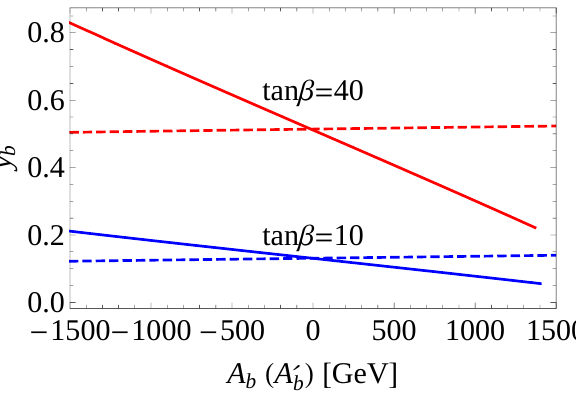
Figure 2 . Variation of y b as a function of A 0 (in the NHSSM with A b = 0; bold lines) and A b (in b the MSSM; broken lines) for tan (cid:12) = 10 (in blue) and for tan (cid:12) = 40 (in red). Some of the (cid:12)xed input parameters are (cid:22) = 200 GeV, (cid:22) 0 = 0, M 1 = 500 GeV and M 2 = 1 : 1 TeV while the rest are presented in table